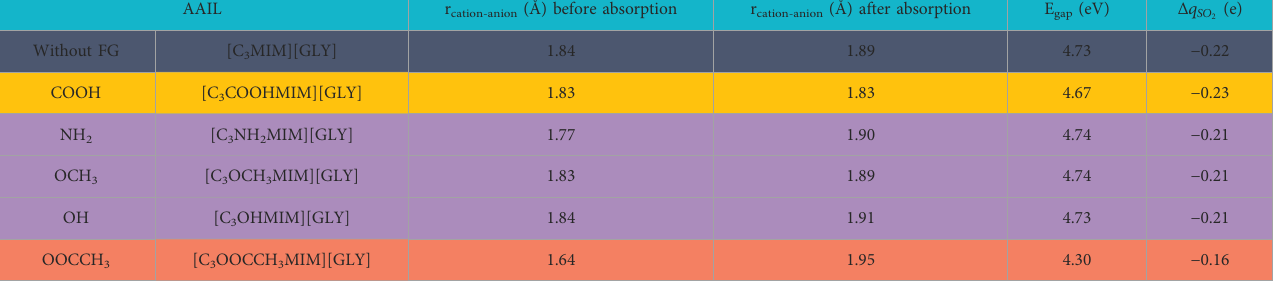
TABLE 1 Distance (Å) between anion and cation (r cation-anion ) before and after absorption as well as SO 2 adsorbed NCTA (e) and E gap (eV). AAIL r cation-anion (Å) before absorption